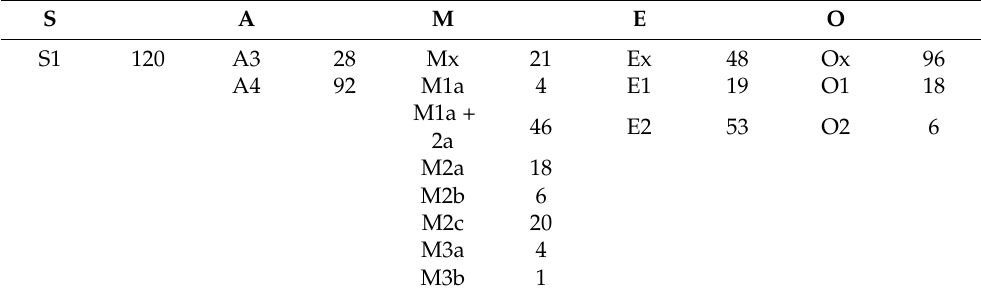
Table 1. Occurrence of individual types of surgical treatment of chronic otitis media with cholesteatoma in the group of 92 patients (120 ears), according to the SAMEO classification. S